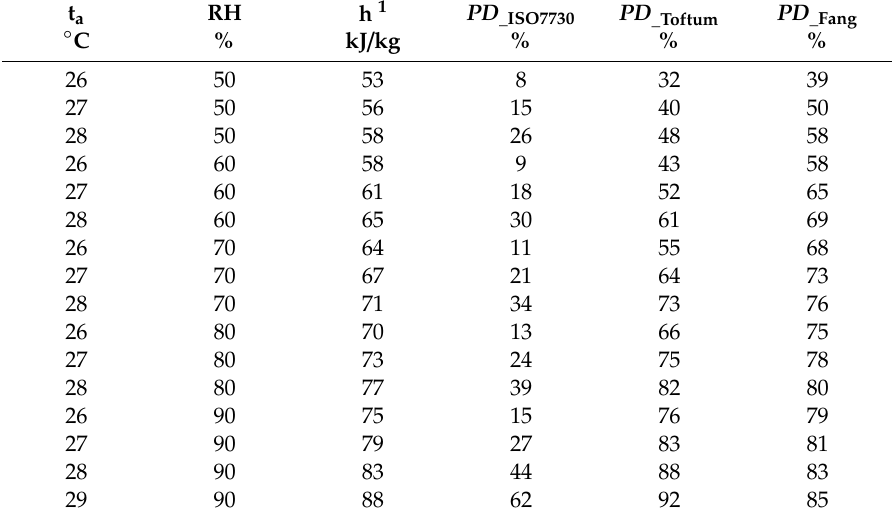
Table 1. Percent dissatisfied ( PD ) estimated for three human comfort models for selected indoor environment data (Monte Carlo method), where PD_ ISO7730 values are estimated using the Fanger thermal comfort model, PD _Toftum is estimated using the indoor air acceptance model (4) and PD _Fang is estimated using the indoor air acceptance model—Equations (2) and (3) (under the assumptions: air speed < 0.1 m / s, 0.6 clo, 1.1 met, t a = t mr